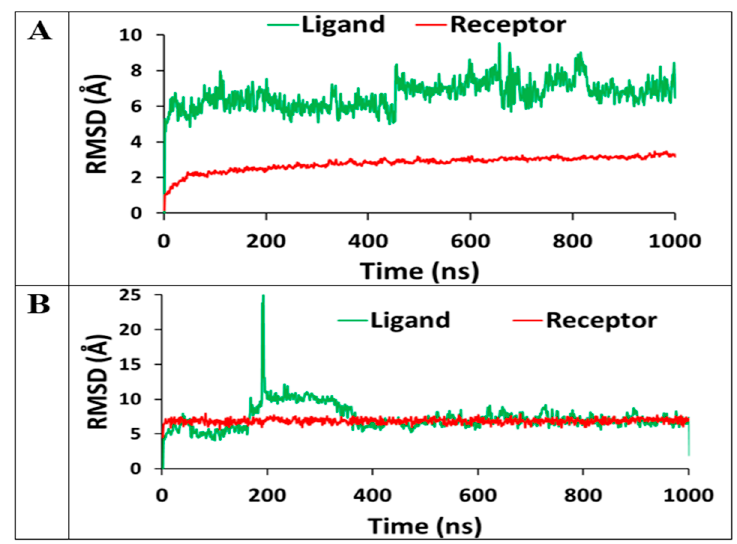
Figure 5. Average RMSD of laccase protein receptor C α atoms (red) and heavy ligand atoms (green) over three 1000 ns trajectories. ( A ) In water. ( B ) In water with TMG-Ser.